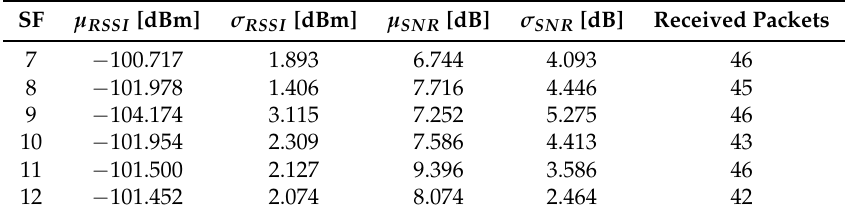
Table 6. Experimental results from group #2.